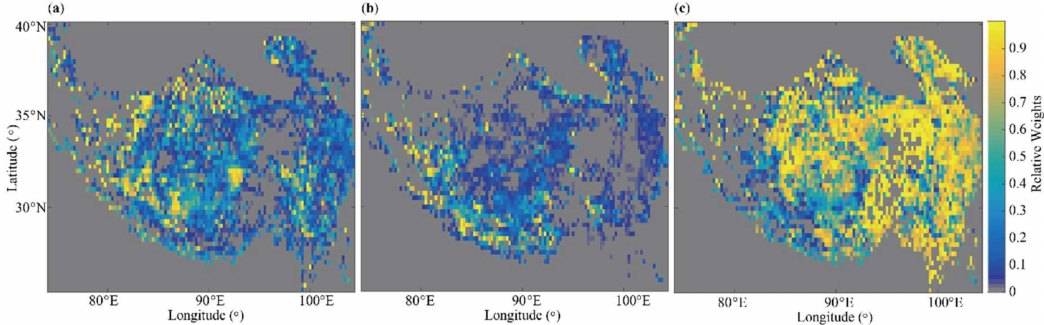
Figure 6. Optimal Weights Distribution of SM Products for Blending: ( a ) Scaled ERA-Interim (in average 0.30); ( b ) Scaled PASSIVE (in average 0.14); and, ( c ) Scaled ACTIVE (in average